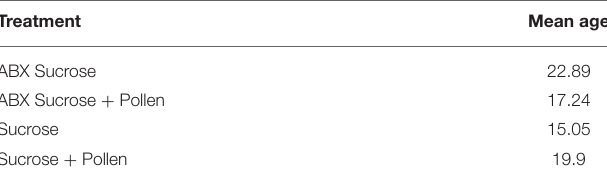
TABLE 2 | Mean age (days) of each treatment group, ABX Sucrose, ABX Sucrose + Pollen, Sucrose, Sucrose + Pollen ( N = 4).